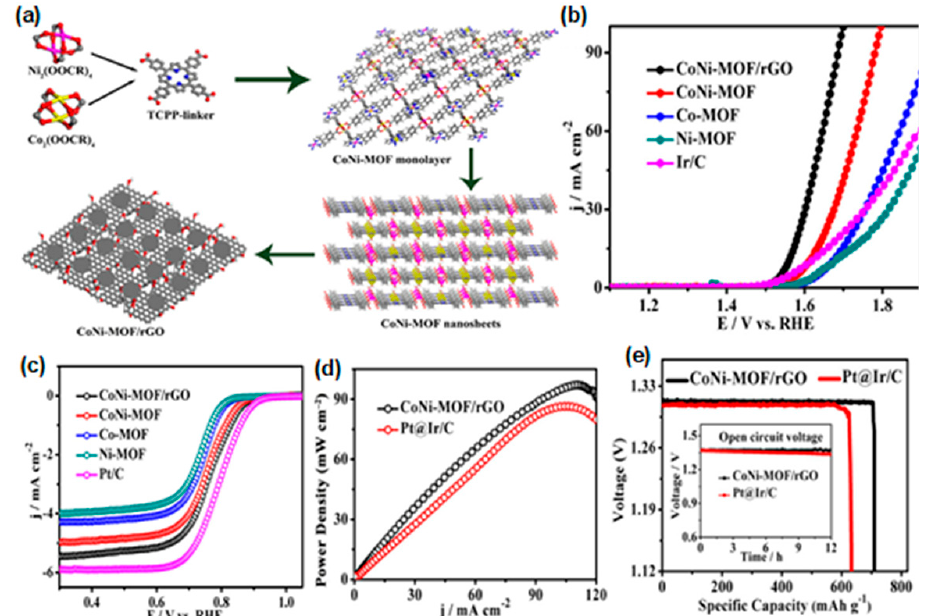
Figure 13. ( a ) Schematic illustration of the preparation of the CoNi-MOF/rGO catalyst; ( b ) OER LSV curves in N 2 -saturated 1.0 M KOH and ( c ) O 2 -saturated ORR polarization curves in 0.1 M KOH (CoNi-MOF/rGO, CoNi-MOF, Co-MOF, Ni-MOF and Ir/C or Pt/C electrocatalyst); ( d ) Corresponding power densities of CoNi-MOF/rGO- and Pt@Ir/C-based Zn–air batteries; ( e ) Corresponding specific capacity and open-circuit plot (inset) of CoNi-MOF/rGO- and Pt@Ir/C-based Zn–air batteries, normalized by the consumed weight of zinc. Copyright 2019 American Chemical Society [126]. Table 2. Summary of ORR/OER performance of MOF-based bimetallic catalysts. ORR OER BET Specific Catalyst Electrolyte RefE E (1/2) V vs. E (overpotential) (onset) V vs. Surface Area Tafel Slope RHE RHE at 10 mA cm − 2